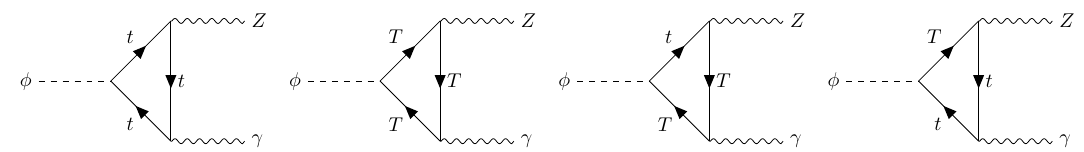
Figure 11. φ → Zγ contributions. For the fermion loops, anti-clockwise diagrams should also be included, as well as contributions from the bottom sector by exchanging t → b and T → B